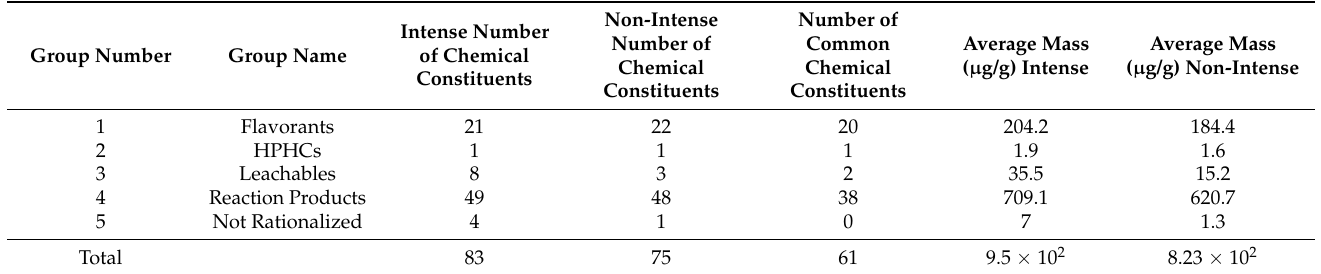
Table 9. Summary of non-targeted analyses of Me5 aerosol constituents detected by GC and/or LC NTA methods using both puffing regimens.